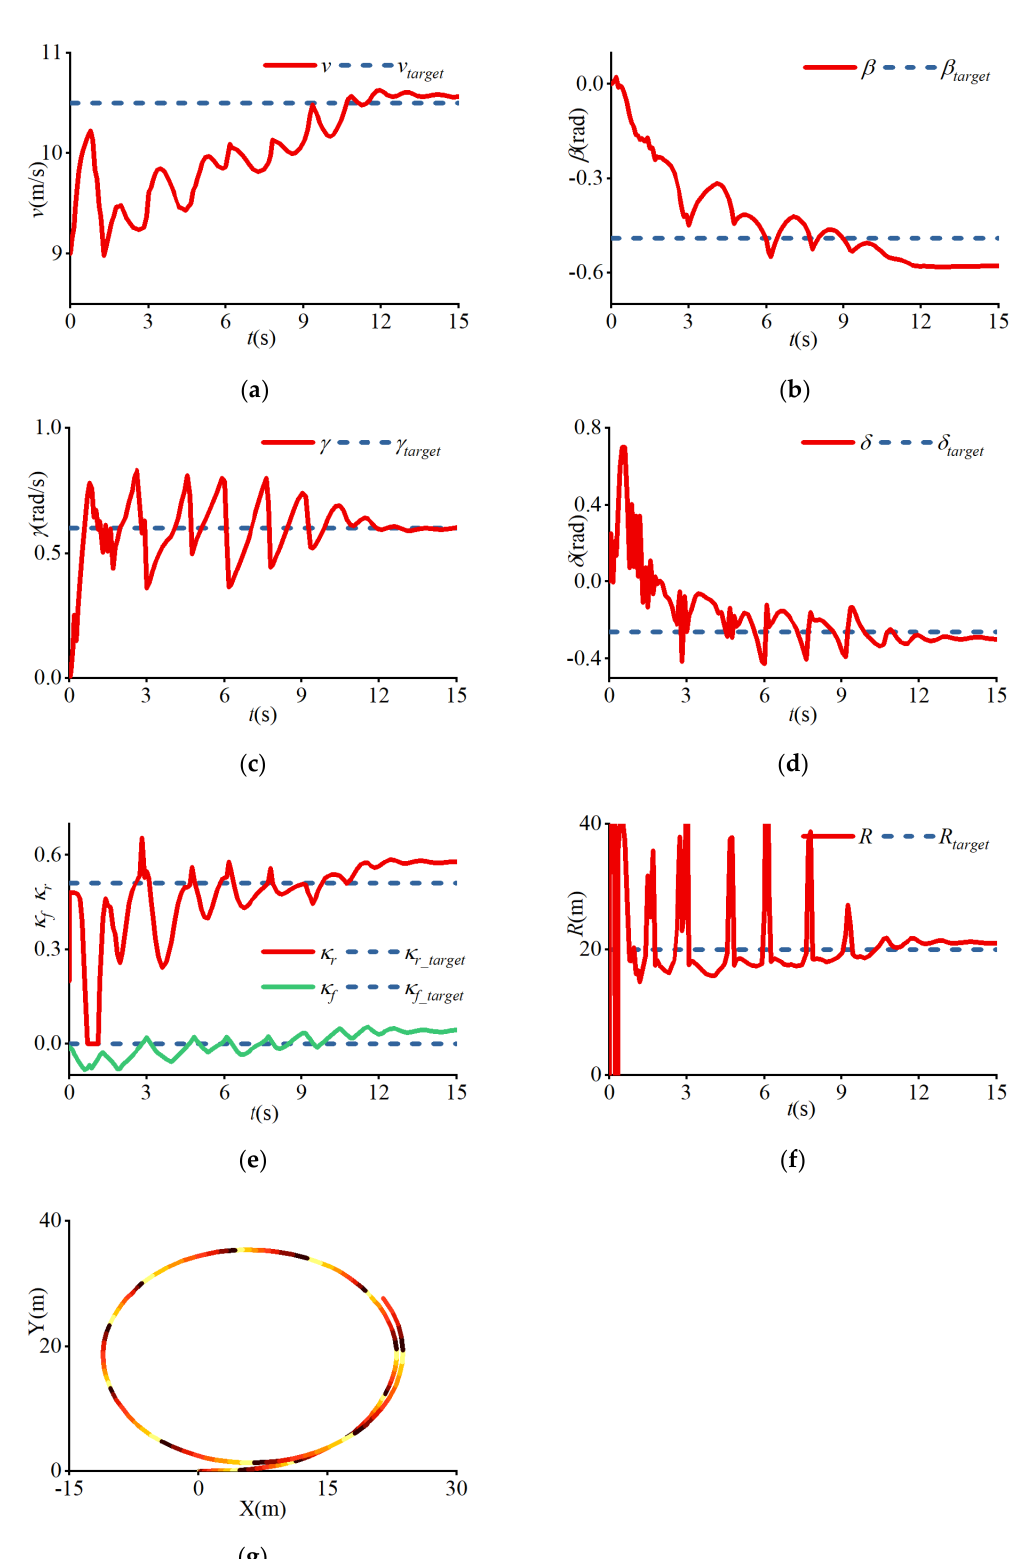
Figure 9. The simulation result with the 9 m/s original velocity and the target group (d): ( a ) the velocity; ( b ) the sideslip angle; ( c ) the yaw rate; ( d ) the steering angle; ( e ) the TYDEX longitudinal slip ratios of the front and rear tires; ( f ) the radius of the motion curve; ( g ) the motion curve of the vehicle. All continuous lines suggest the simulation results, while the dashed lines suggest the targets.